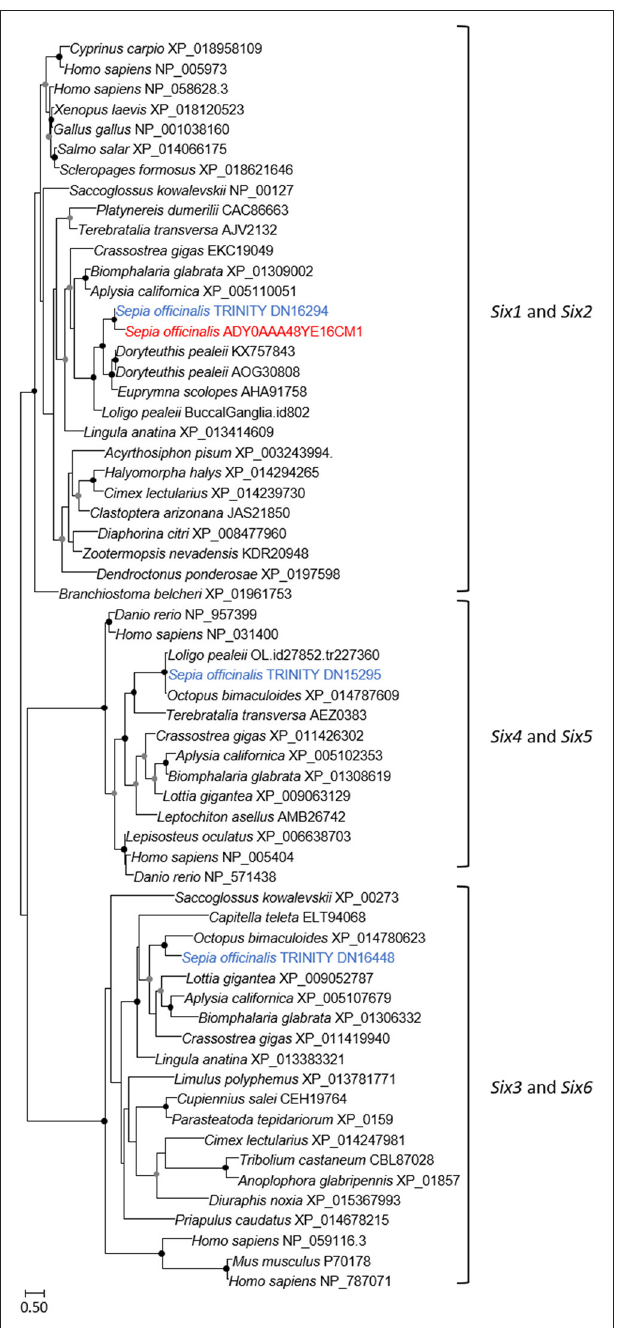
FIGURE 4 | Diversity of sine oculis homeobox (SIX) family. Maximum-likelihood tree based on 183 aligned amino-acids. The specific S. officinalis EST is shown in orange, and the S. officinalis contigs/genes are shown in blue. For the color code used for the bootstraps refer to Figure 3 legend.